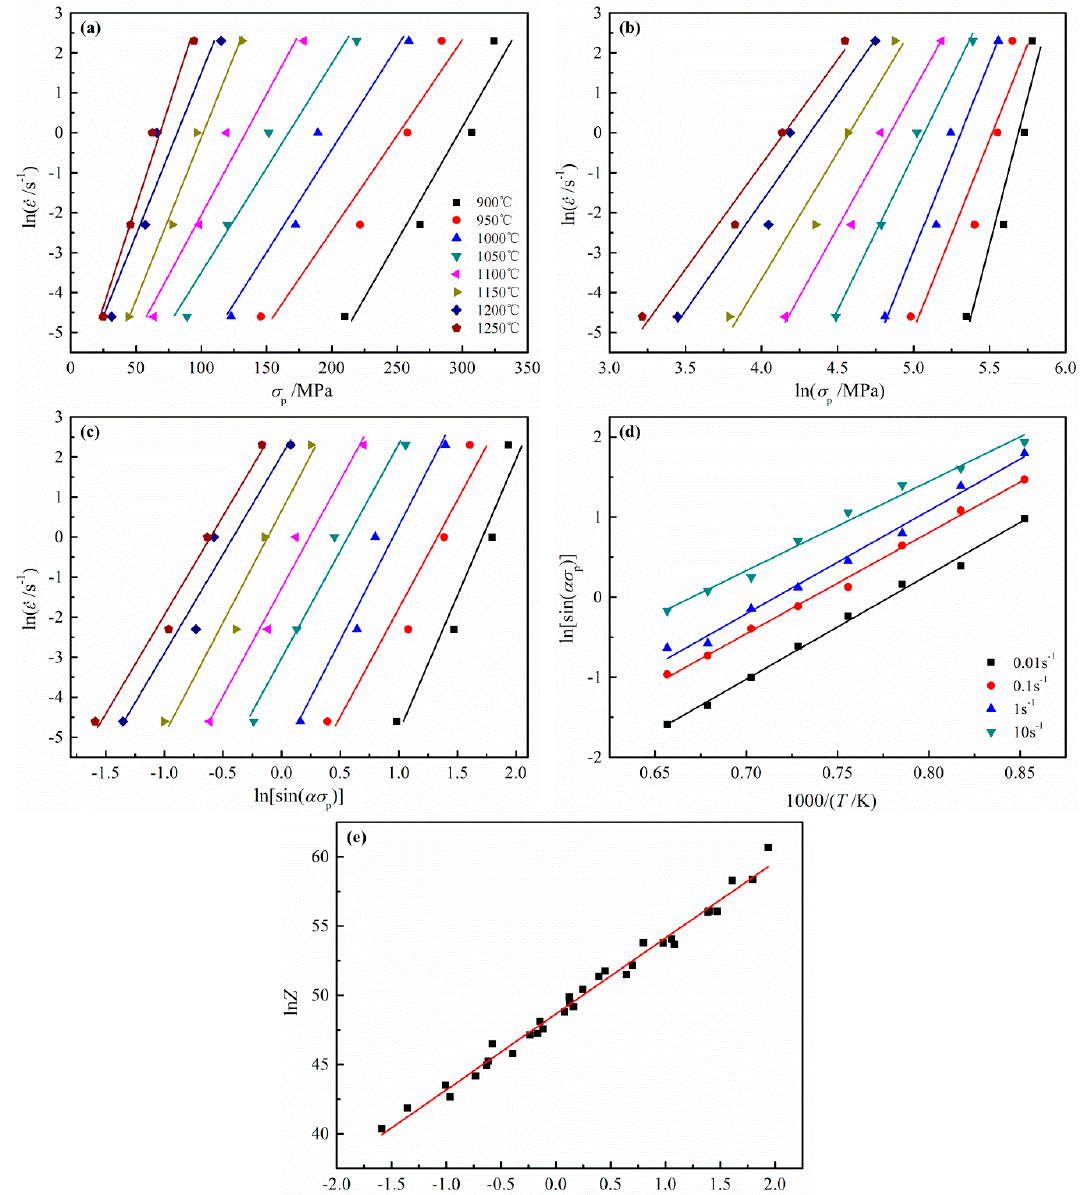
Figure 10. Relationships among flow strain rate and temperature for 2707 HDSS under hot compression: ( a ) ln ε − σ ; ( b ) ln ε − ln σ ; ( c ) ln ε − ln[sinh( ασ )]; ( d ) ln[sinh( ασ )] − 1000/ T ; ( e ) ln Z − ln[sinh( ασ )].